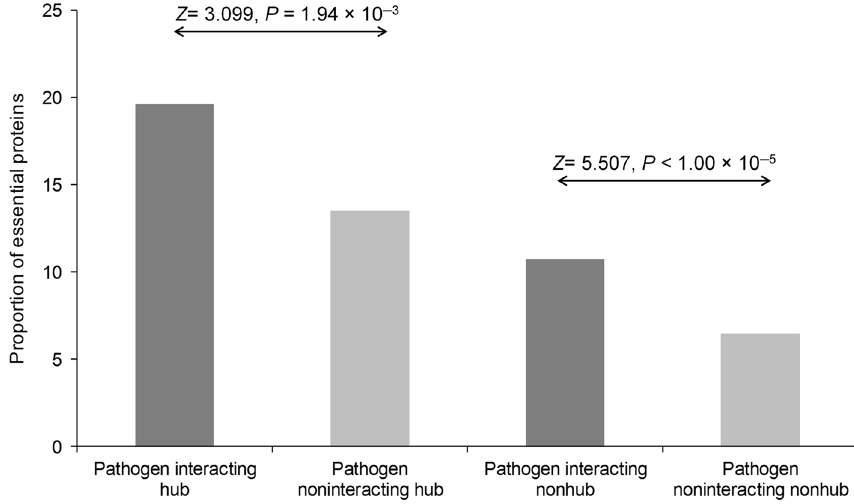
Figure 2. Proportion of essential proteins in pathogen-interacting and noninteracting hubs and nonhubs.